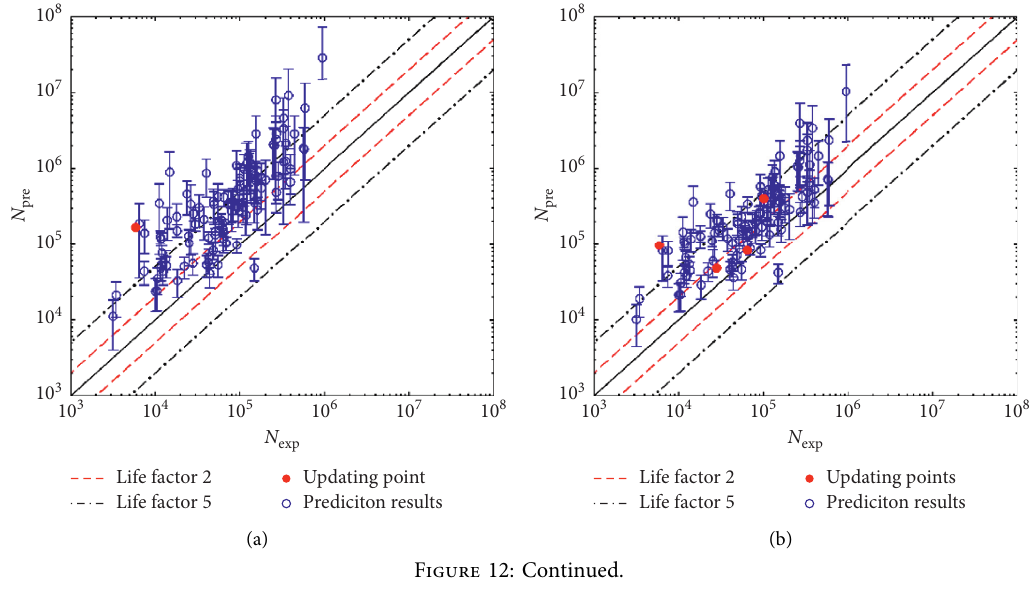
Figure 11: The prior and posterior distributions of model parameters (diameter: 12mm). (a) Parameter A parameter A 3